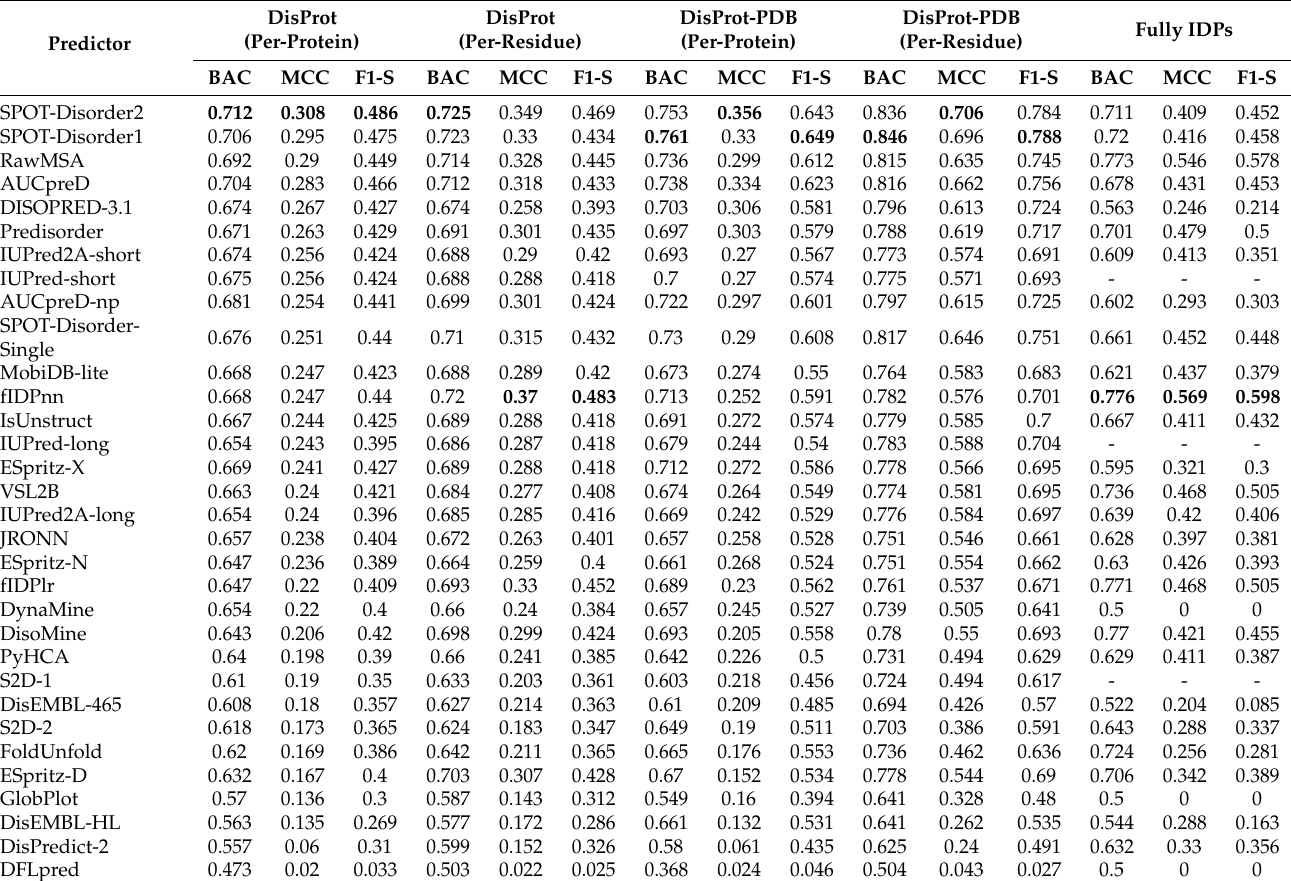
Table 3. Predictive performance of disorder predictors in